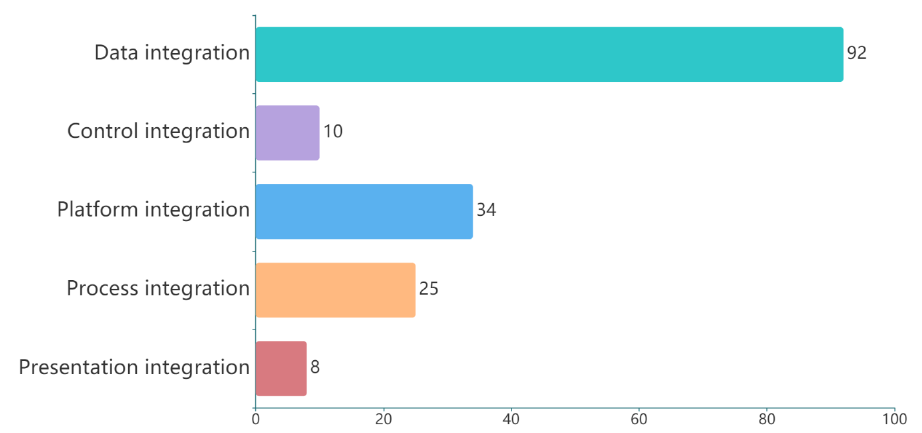
Figure 15. Tool integration in MBSE tool-chains.